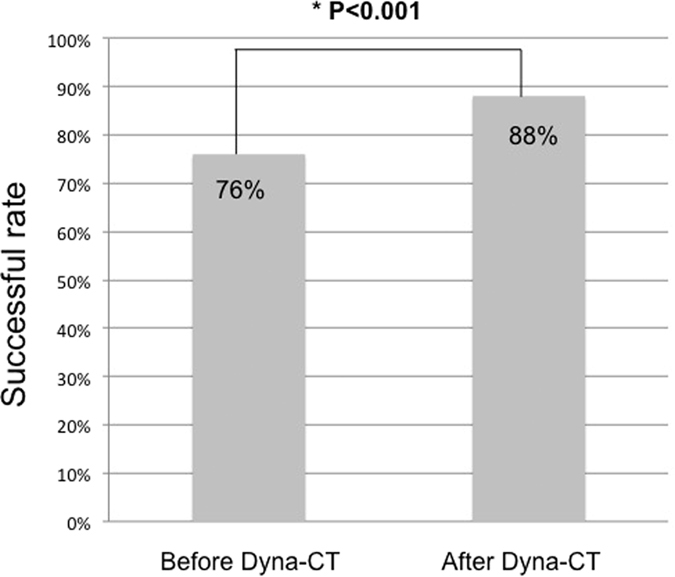
The success rate of non-stimulated adrenal venous sampling (AVS) before and after incorporating Dyna computed tomography (CT).The success rate of the initial sampling during right AVS was 76% (76/100), which increased to 88% (88/100) after Dyna CT was incorporated (p < 0.001).